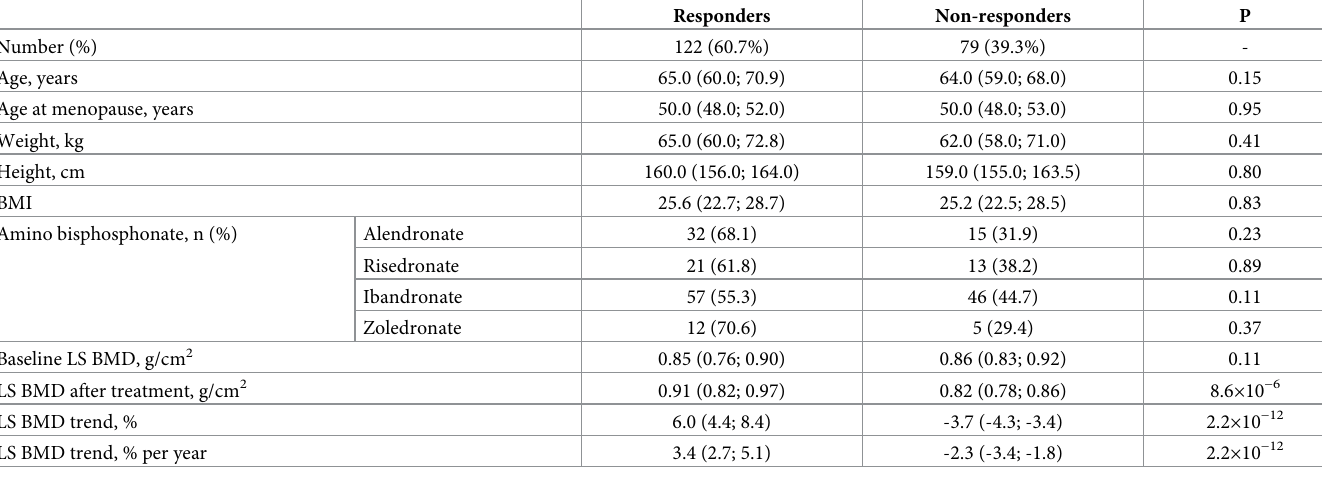
Table 1. Clinical characteristics of study